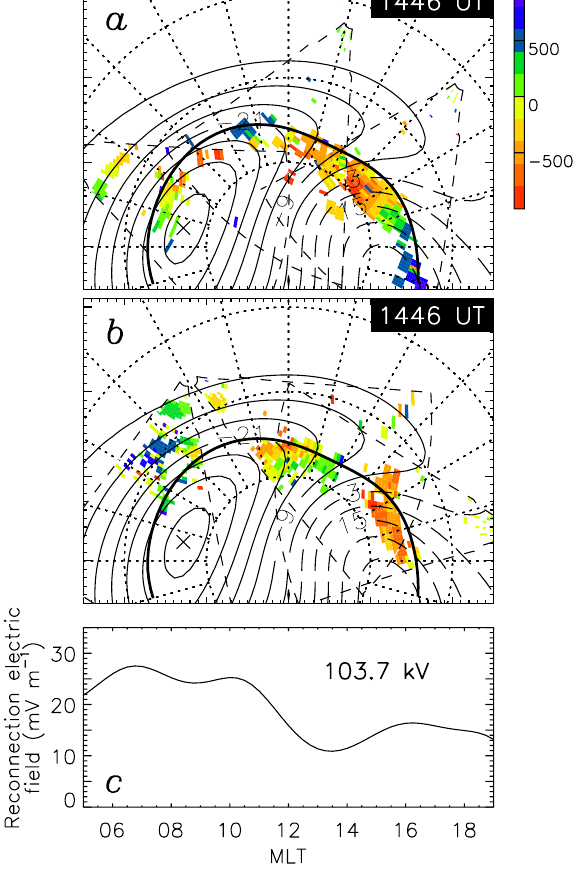
Fig. 8. (a) The line-of-sight plasma drift velocities deduced from the radar observations at 14:46UT, during the growth phase of the second substorm. Positive and negative velocities are towards and away from each radar, respectively. Radars (west to east) Kapuskasing, Goose Bay and Han- kasalmi are shown. Superimposed are contours of the electrostatic potential (solid/dashed lines are negative/positive potentials with a contour interval of 6kV) inferred from the line-of-sight ve- locities (see text for details). Also indi- cated is the location of the OCB (solid line) determined from the equatorward edge of high spectral width backscat- ter. (b) Similar to panel (a), though showing the radar observations from the (west to east) Saskatoon, Stokkseyri, and Pykkvibær radars. The potential so- lution and OCB are the same in (a) and (b). (c) The reconnection electric field determined from the plasma drift per- pendicular to the OCB. The integral of this along the boundary between 05 and 19 MLT is shown in the top right-hand